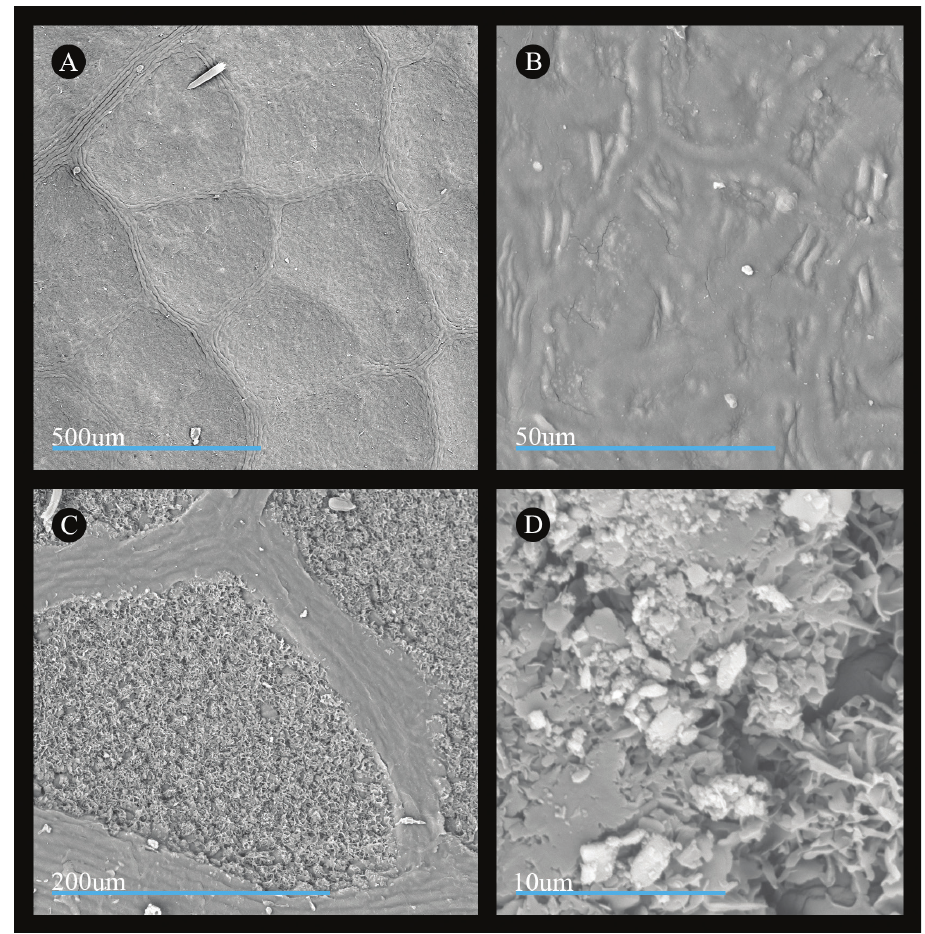
Figure 6. Micrographs of the leaf surfaces of Acer laurinum . A Adaxial surface showing cell shape and organization ( Cult., in Hort. Bog. III,K,37 ) B Adaxial surface showing cuticle ( Sandkuhl 21296 ) C Abaxial surface showing cell shape and organization of cells and stomata ( Sandkuhl 21296 ) D Abaxial surface showing cuticular wax ( Wen 13386 ). All leaf materials are from specimens deposited at US, parenetical information in this legend refers to the collector name and